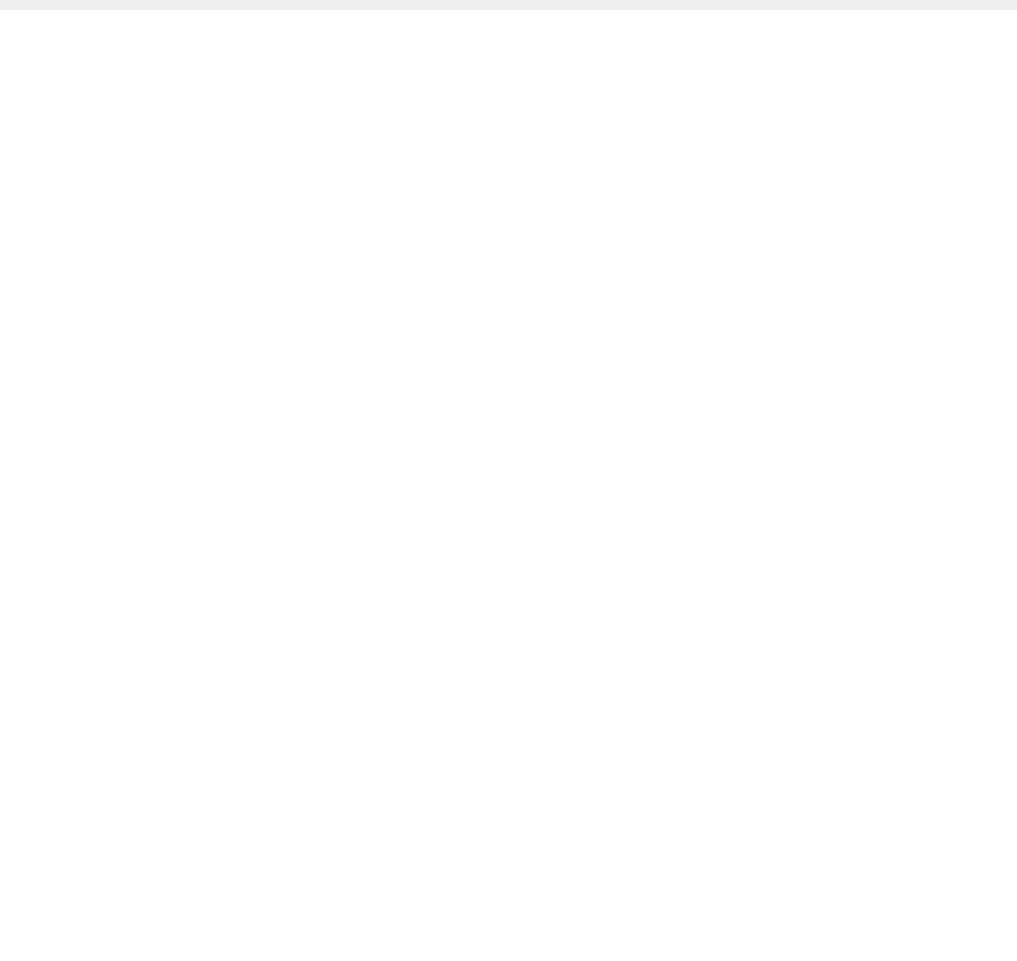
Time trends in avoidable cancer mortality and remaining cancer deaths (age-standardised mortality rate [ASMR], European standard) by country and sex, time period 1996–2010. Note: For Italy, data are lacking for 2004 and 2005. For France, data are lacking for